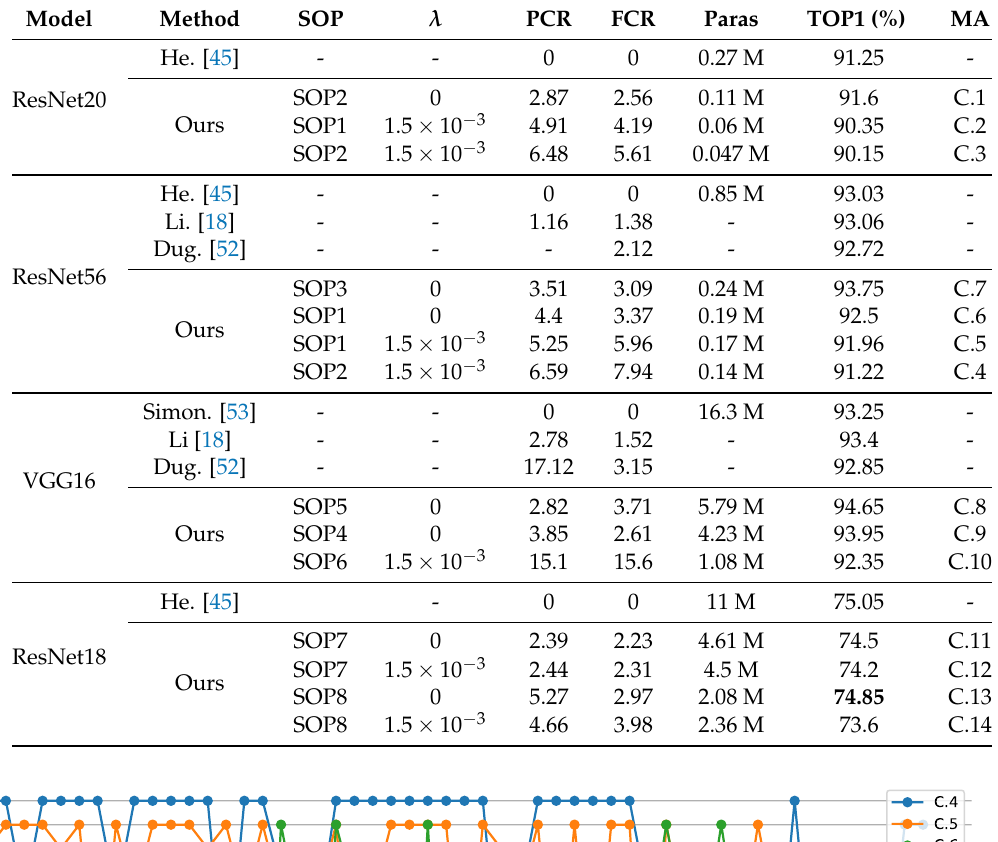
Table 2. Results of compressing ResNet20, ResNet56, VGG16 on Cifar-10 and ResNet18 on Cifar-100. SOP represents the set of operators used in the reconstructed CNN. TOP1 refers to the TOP1 accuracy of the model on the test set. MA is the architecture of the compressed model, as shown in Figures 5–7. Paras represents the number of parameters in the CNN, containing the number of parameters of all